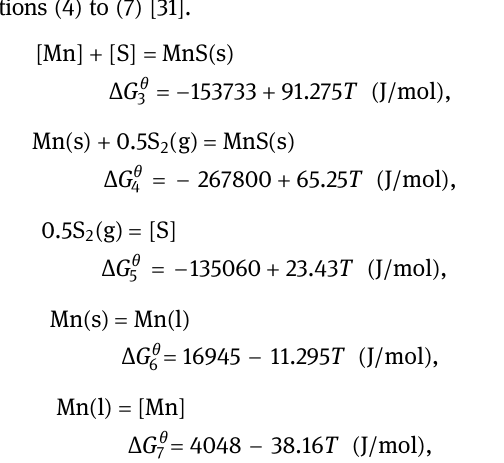
Table 2: Values of ζ Δ Elements